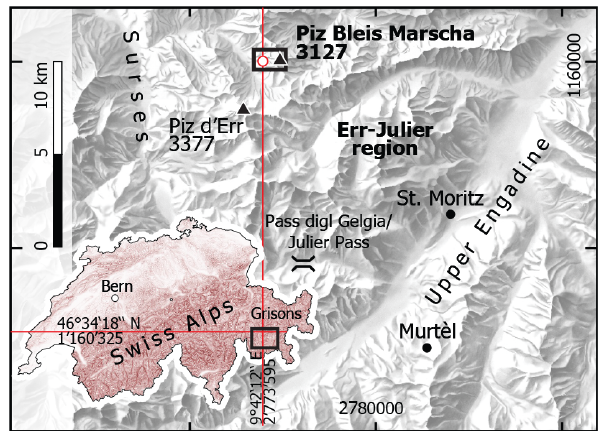
Figure 1. Location of the Bleis Marscha rock glacier to the west be- low Piz Bleis Marscha in the Err–Julier region, eastern Swiss Alps. The rectangle shows the area covered by the geomorphological map (Fig. 3). Inset map: location and extent (black rectangle) of the Err– Julier regional map within Switzerland and the coordinates of the lowermost front of the Bleis Marscha rock glacier (maps reproduced with the authorization of the Swiss Federal Office of Topography,